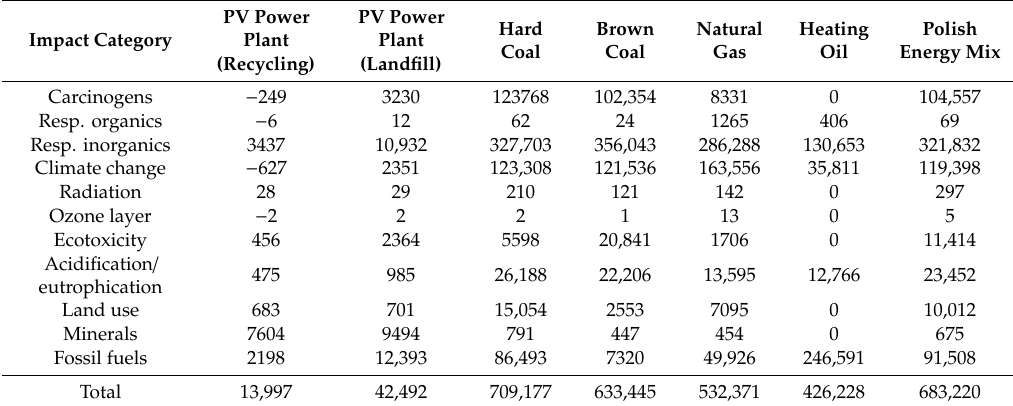
Table 16. Results of grouping and weighting of environmental consequences arising as a result of generating 20,000 MWh of electricity from selected energy sources [unit: